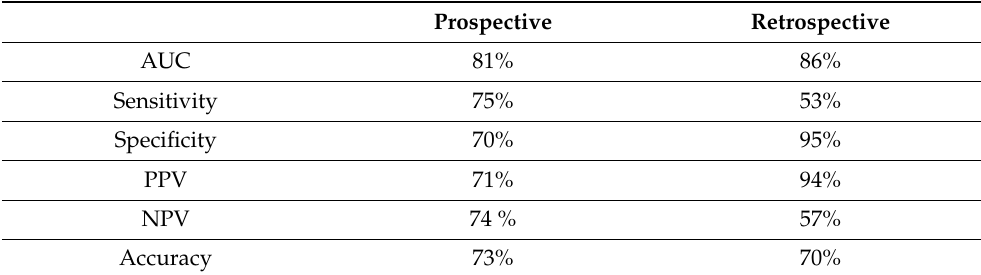
Figure 5. Receiver operating characteristics (ROC) curves of the three miRNAs signature (miR-11400, miR-148a-3p, and miR-409-3p) for the discrimination between preclinical MPM and matched controls (solid line), as well as for discriminating between MPM at diagnosis and healthy controls (dashed line). The area under the curve (AUC) shows the percentage of correct discrimination associating sensitivity (Y) and 1-specificity (X). Table 2. Diagnostic accuracy of miR-11400, miR-148-3p, and miR-409.